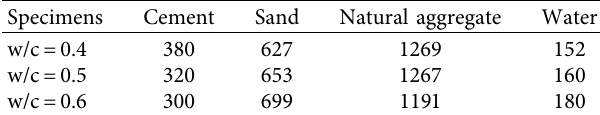
Table 1: Mix proportion of plain concrete (kg/m 3